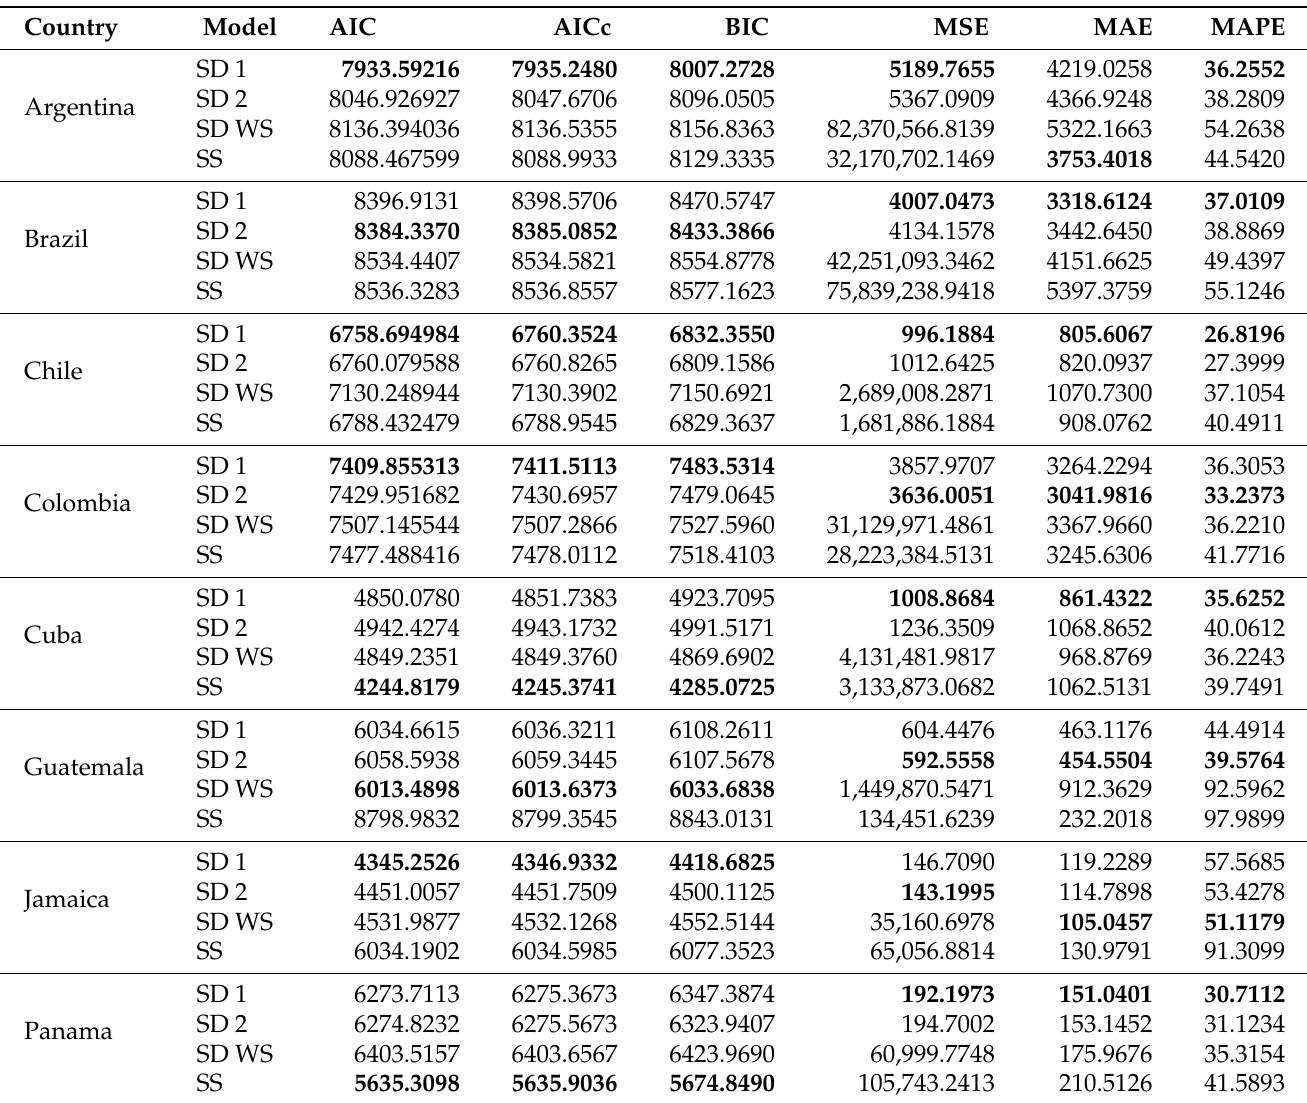
Table 4. AIC, AICc, BIC, and loss functions (forecasting window: last 28